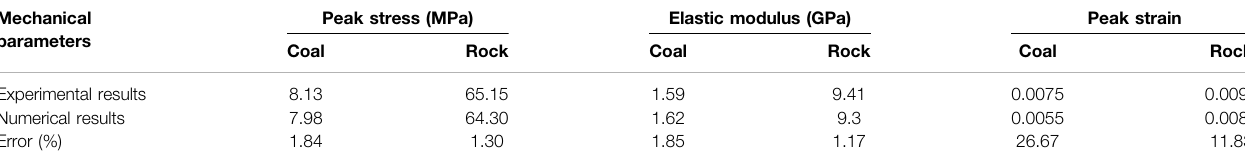
different from the numerical simulation results, as the errors are within 1.85%. This is consistent with the trends of the two sets of curves in Figure 4 , which indicate that the elasticity modulus and